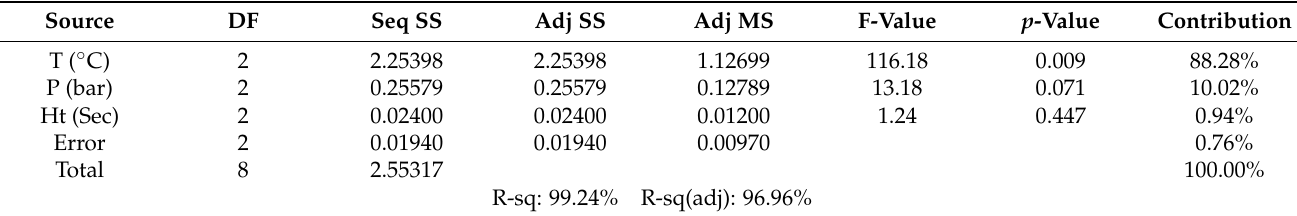
Table 4. ANOVA table for nano-hardness.